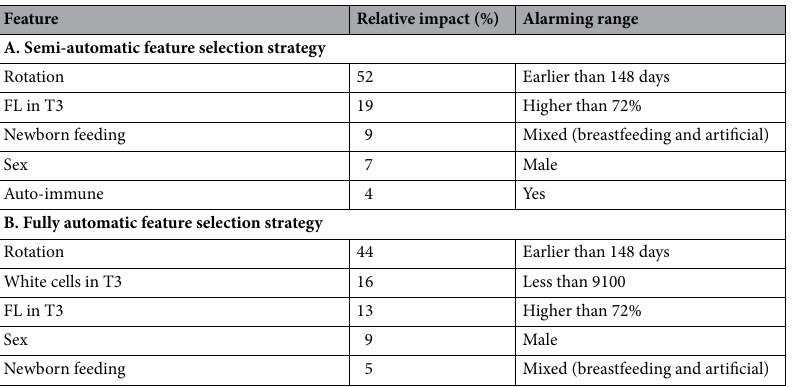
Table 2. Features with the highest impact on the classifier based on SHAP analysis. For each feature, the relative impact and the alarming range, i.e. the range of values that push the classifier to ASD decision, are presented. T3, third trimester. Rotation, timing of fetal rotation on head; FL, femur length percentile; Auto- immune, familial maternal history of auto-immune diseases.